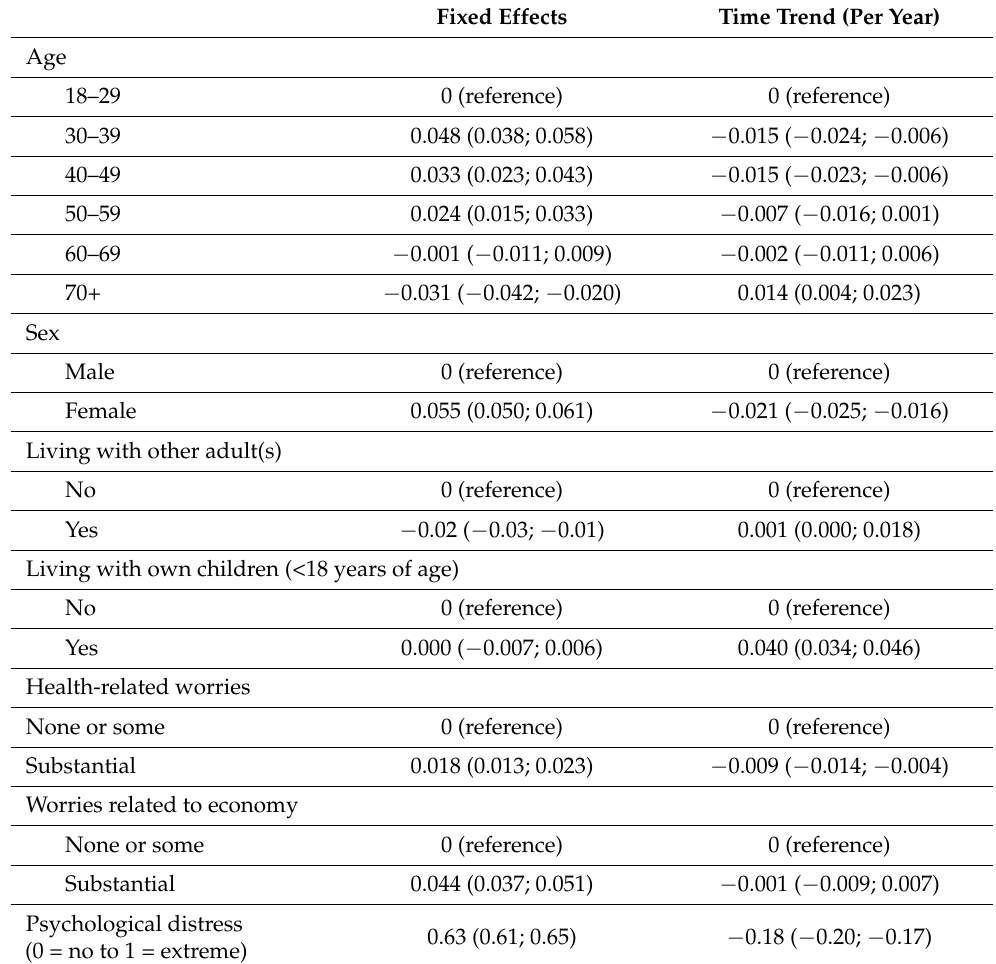
Table 2. Degree of emotional eating and associations to psychological distress, worries and baseline characteristics (linear mixed model presenting absolute coefficients with 0 indicating no differ- ence/change, >0 indicating higher frequency of emotional eating within group and <0 indicating less emotional eating within